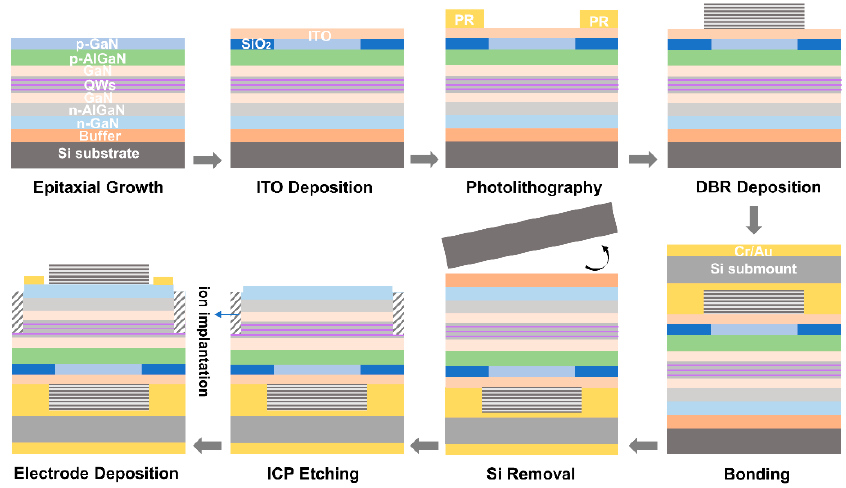
Figure 2. The detailed fabrication process flow of the GaN-based RCLED grown on Si.